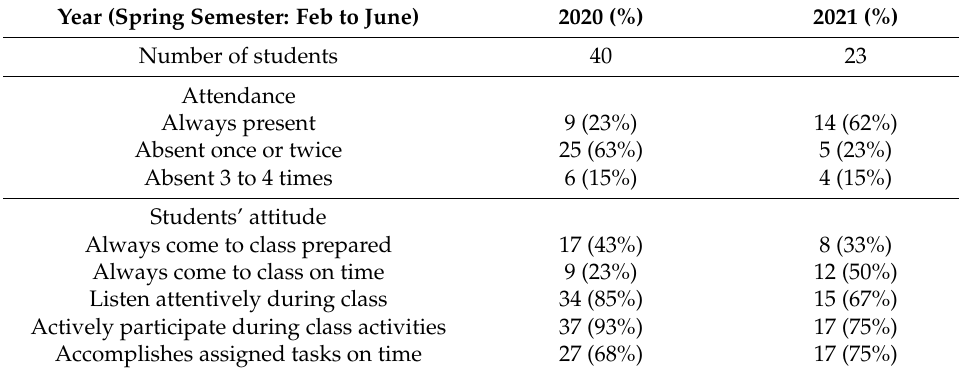
Table 1. Students’ attendance and course attitudes.